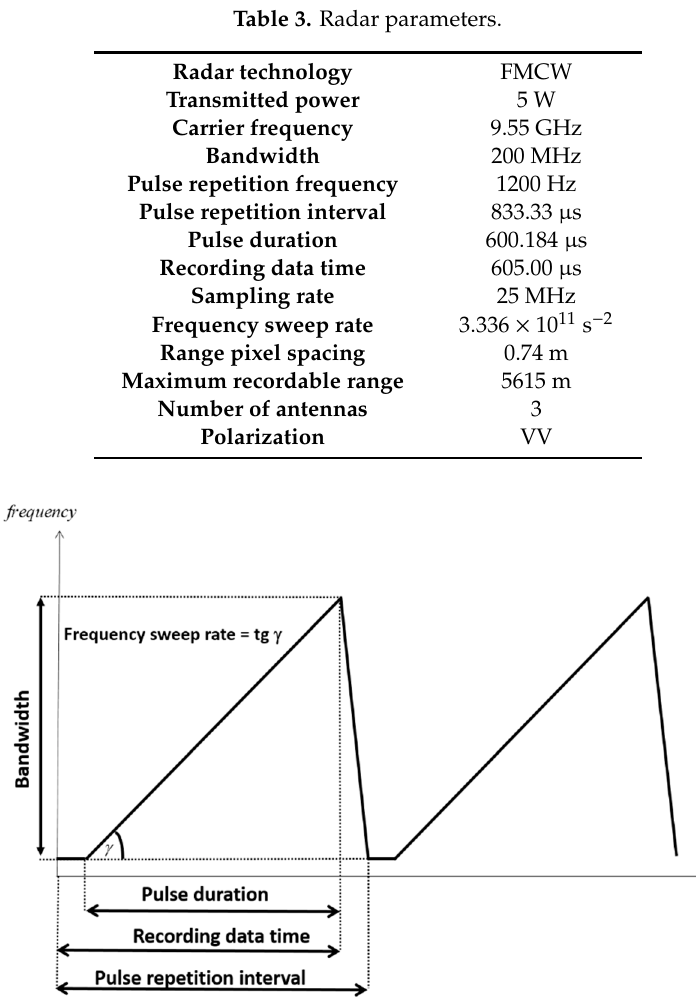
Figure 4. Operating principle of a FMCW SAR.